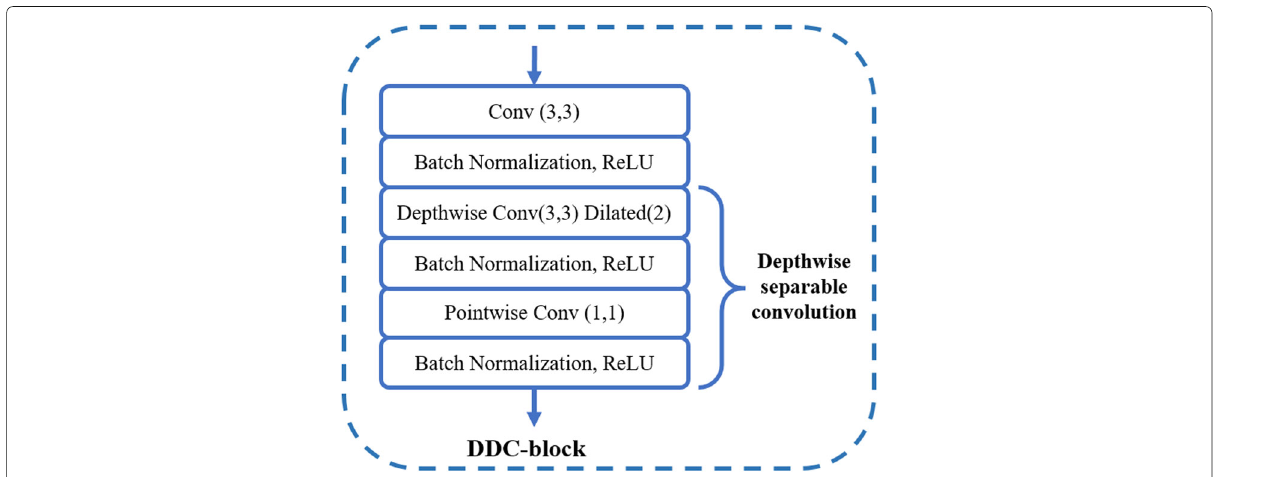
Fig. 2 The internal structure of DDC-block module